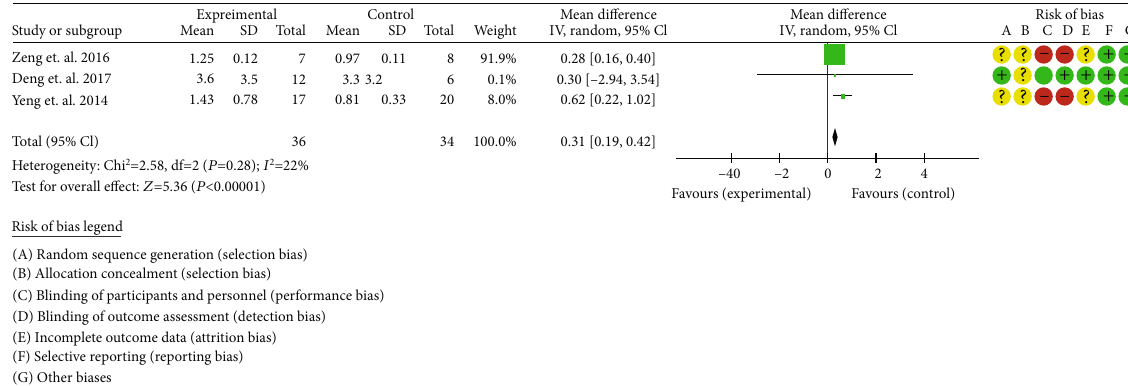
Figure 6: Serum C3 (CI: con fi dence